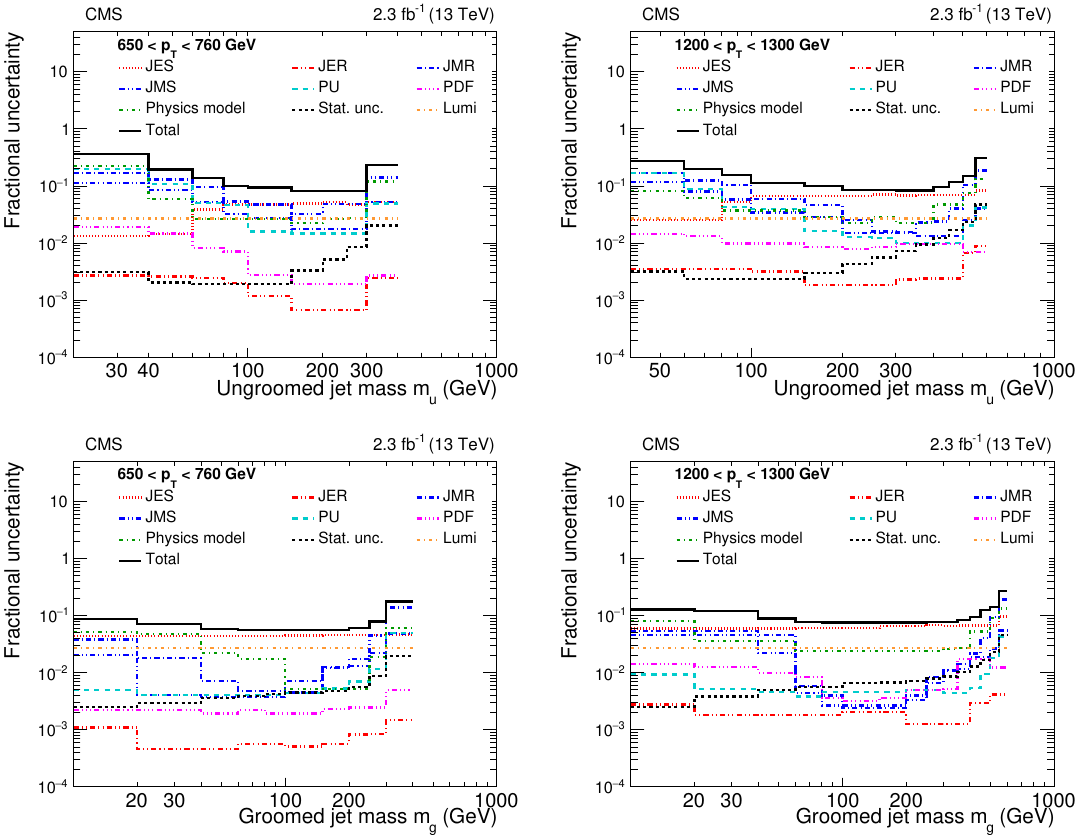
Figure 4 . Systematic uncertainties in the absolute cross section after unfolding for two p T bins before grooming (top) and after grooming (bottom). The red dotted lines show the JES uncer- tainties. The red dash-dot-dotted lines show the JER uncertainties. The blue dash-dotted lines show the JMR uncertainties. The blue dash-dot-dotted lines show the JMS uncertainties. The cyan dashed lines show the PU uncertainties. The orange dash-dotted lines show the luminosity uncertainties. The magenta dash-dot-dot-dotted lines show the PDF uncertainties. The green dash- dotted lines show the physics model uncertainties. The black short-dashed lines show the statistical